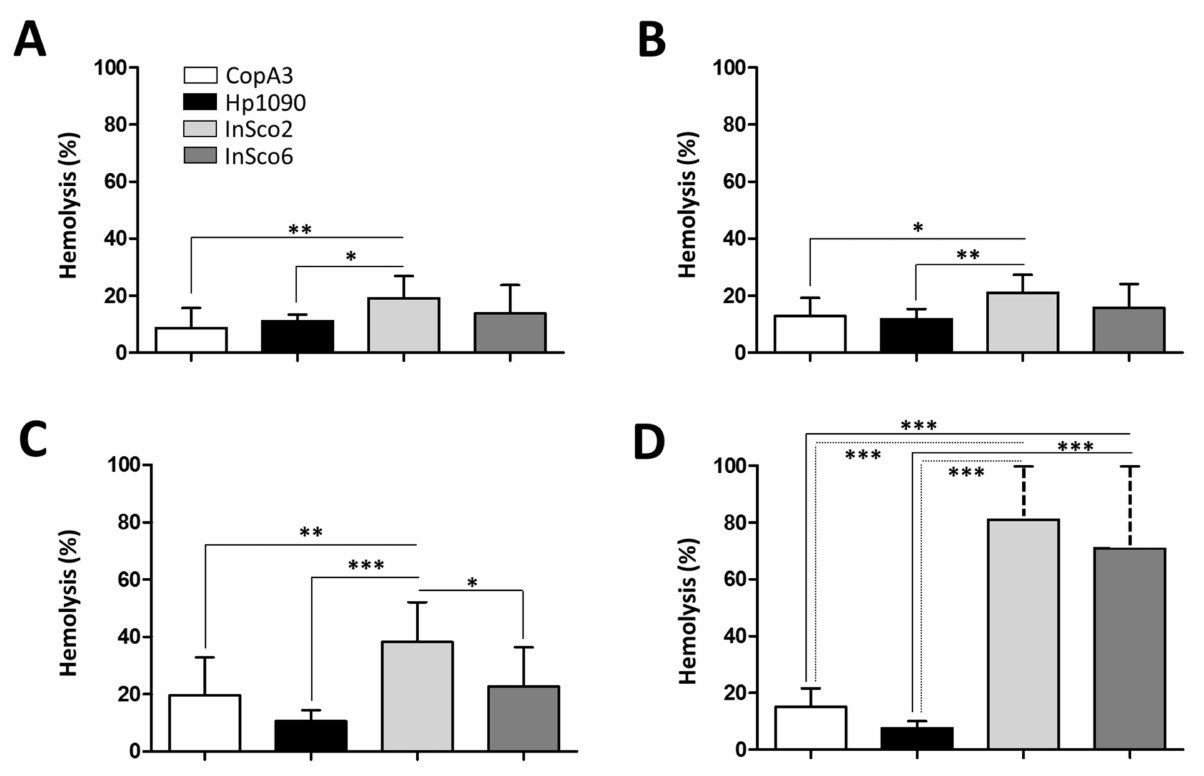
Figure 4. Hemolytic profile of the parental and hybrid AMPs. CD-1 mouse erythrocytes were incubated with the four AMPs to evaluate their hemolytic profiles at four concentrations: ( A ) 0.1 µ M, ( B ) 1 µ M, ( C ) 10 µ M and ( D ) 100 µ M. Results were compared by one-way ANOVA with Tukey’s multiple comparison test applied for individual comparisons (significant differences between AMPs are indicated as follows: * p < 0.05; ** p <0.001; *** p <